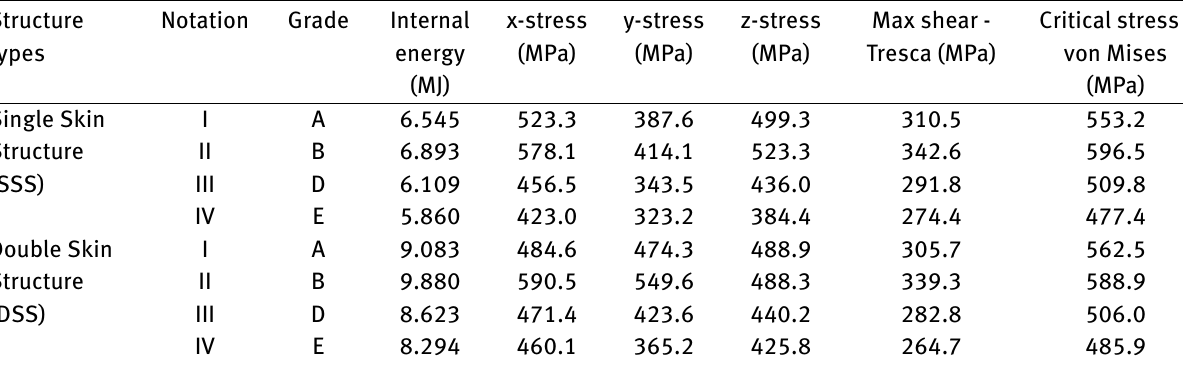
Table 4: Energy absorption and structural responses after side impact on the side